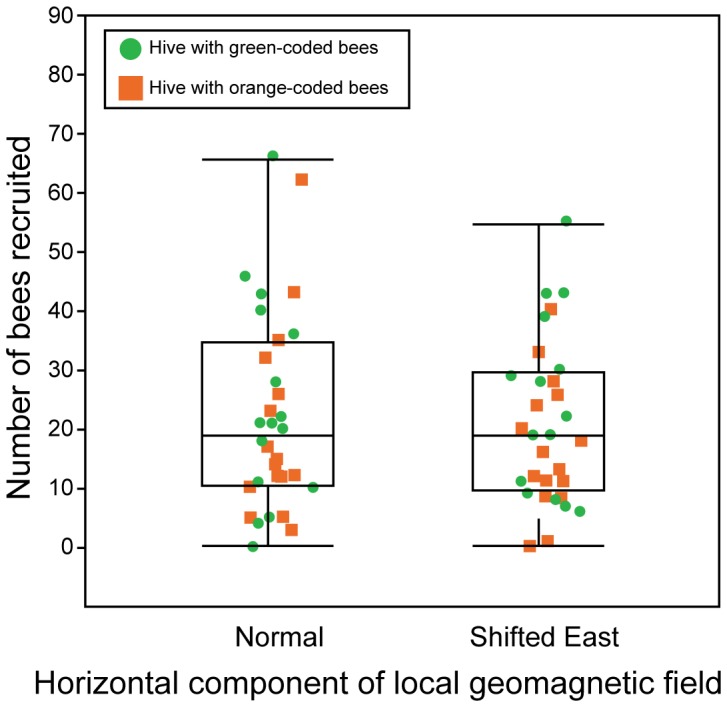
Effect of shifting the declination of the ambient magnetic field to the East on the recruitment success of waggle-dancing bees.Boxplots show the mean, median, lower and upper quartiles, and ± whiskers (minimum/maximum data points) of the number of honeybee nest mates recruited to a feeding station when the hive was exposed to either the ambient magnetic field (control session) or to the magnetic field with its declination shifted East (treatment session) (see Fig. 1, C3). In each replicate (N = 15), treatment and control sessions were run concurrently using a single-frame observation hive with green- or orange-coded bees in each of two separate but identical Helmholtz coil systems (one of which is shown in Fig. 1B). The number of nest mates recruited from hives in treatment or control sessions did not differ (linear mixed effect model analysis; F1,14 = 0.0274, p = 0.87).